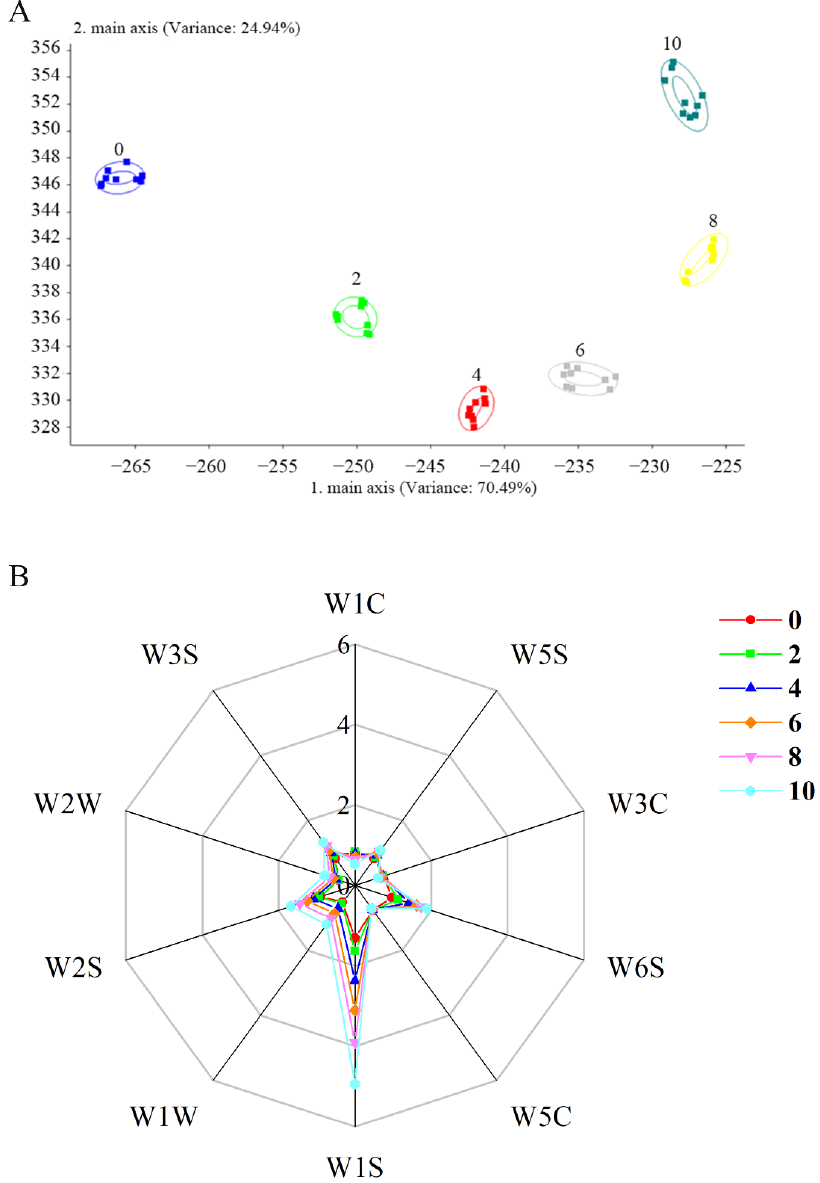
Figure 4. The analysis of shrimp head by E-nose. ( A ) the linear discriminant analysis of E-nose; ( B ) The Radar chart analysis of E-nose.